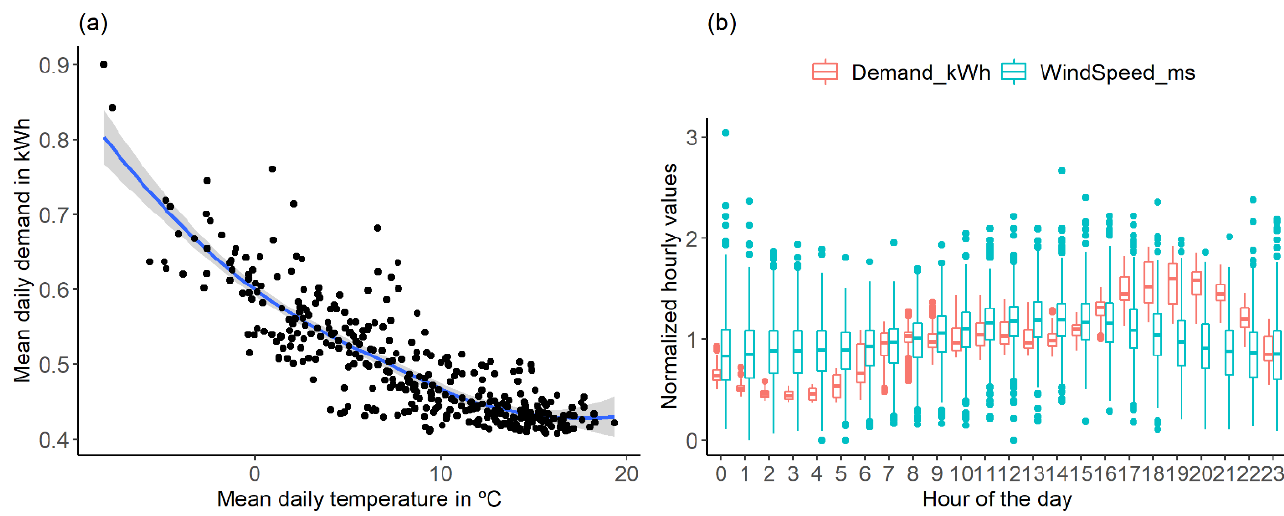
Figure 6. Weather conditions in relation to energy demand and shape patterns. ( a ) Mean hourly daily demand for all customers in kWh versus mean daily temperature. ( b ) Daily mean normalized hourly values of hourly energy demand and hourly wind speed for each hour of the day.